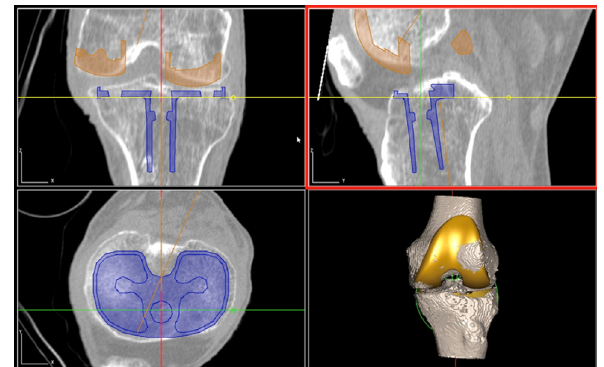
Figure 1. Virtual surgery conducted using TPLAN (cid:2) 3D workstation.